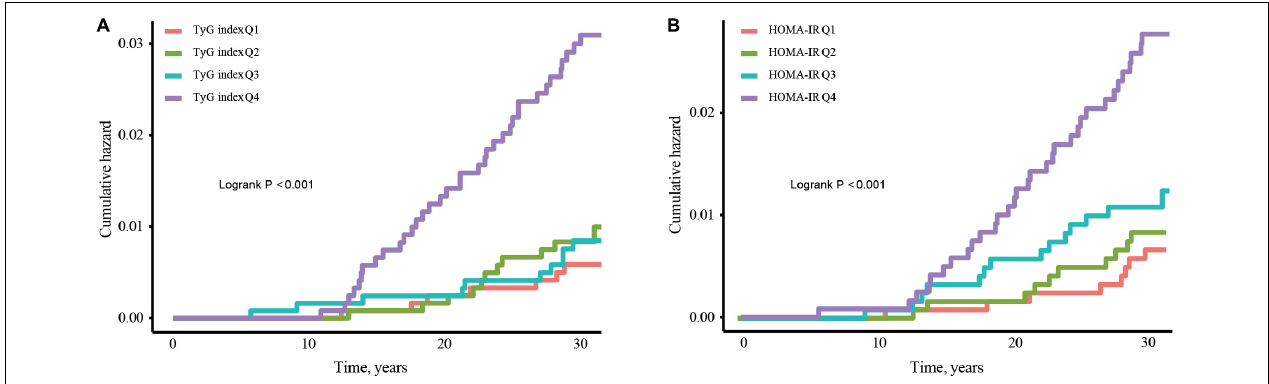
FIGURE 2 | Kaplan–Meier curves for incidence of CHF stratified by quartiles of TyG index (A) and HOMA-IR (B) . Abbreviations: TyG, Triglyceride-glucose; HOMA-IR, homeostasis model assessment-insulin resistance; CHF, congestive heart failure.